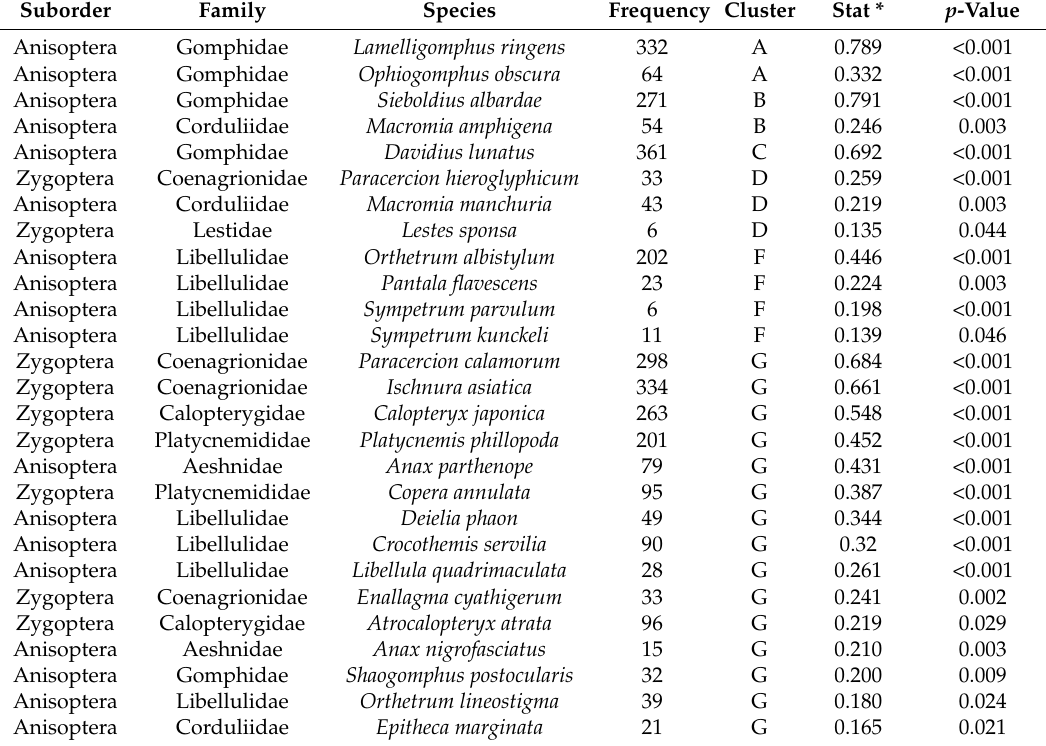
Table 2. Indicator species of each cluster based on the